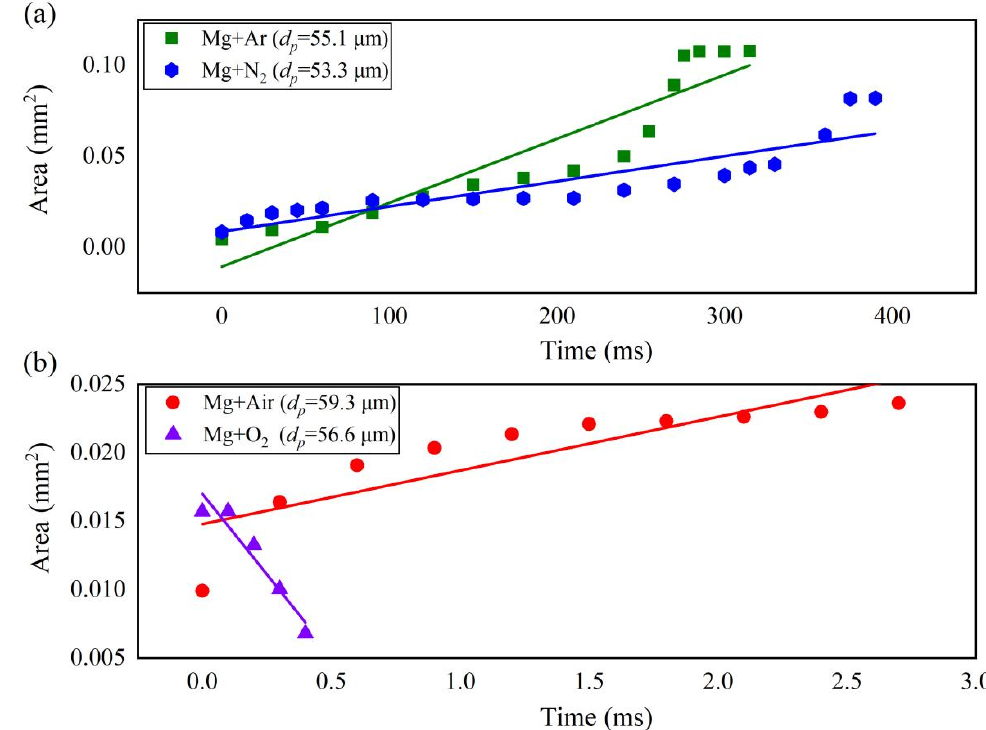
Figure 5. The diffusion rates of Mg vapor in different atmospheres ( a ) in Ar and N 2 ; ( b ) in Air and O 2 .